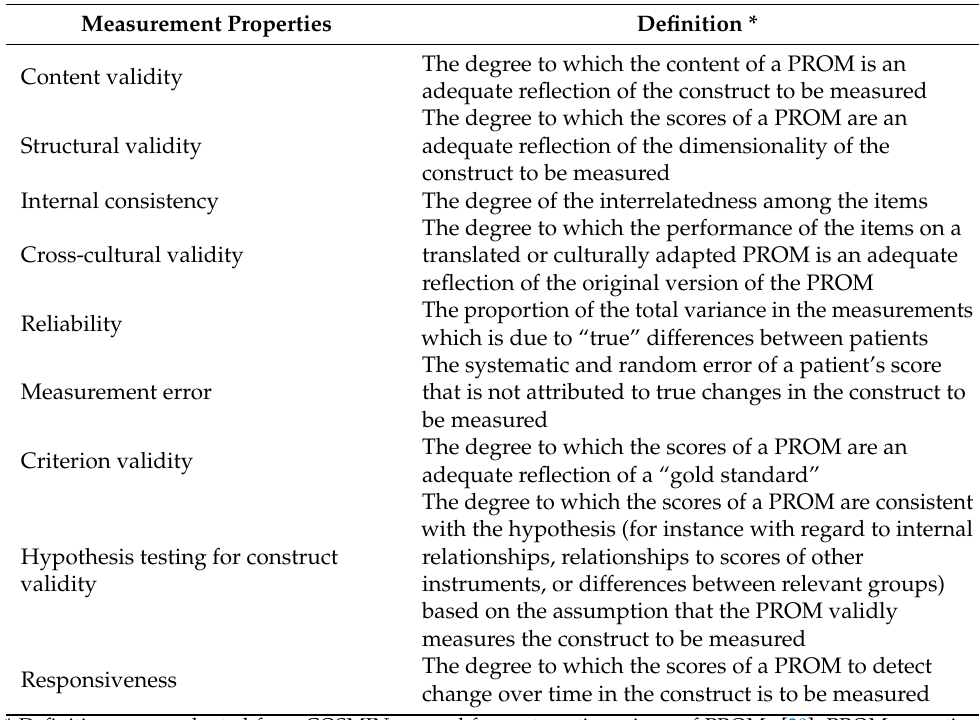
Table 1. COSMIN definitions of measurement